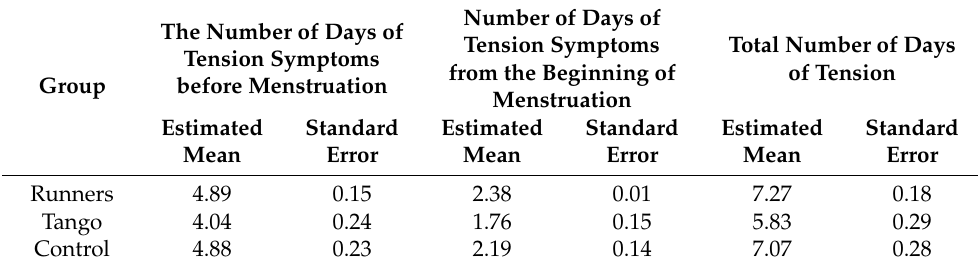
Table 5. Estimated means and standard error of duration of PMS symptoms related to menstruation in the runners, dancers, and control groups.